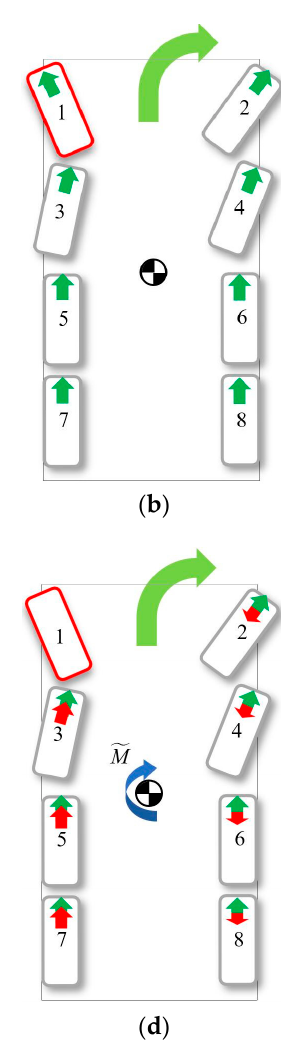
Figure 4. Fail-operation steering of the vehicle. ( a ) Vehicle parameters; ( b ) fail-operation without lateral control; ( c ) fail-operation with DTD control; ( d ) fail-operation with OTD control.